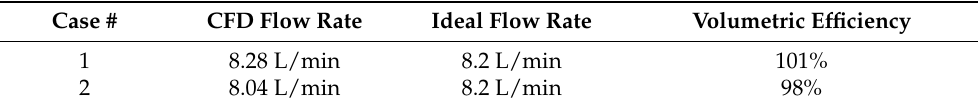
Figure 11. Experimental volumetric efficiency of the pump (blue) and CFD result in Case #2 (or- ange).